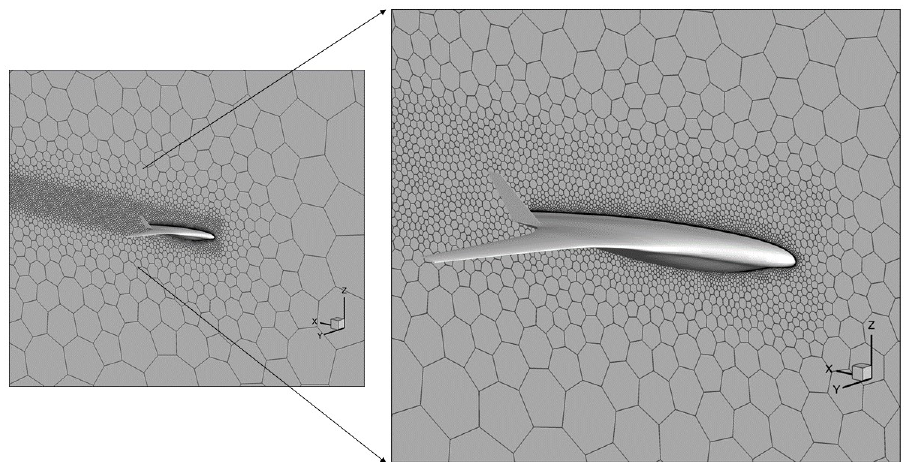
Figure 5. Unstructured polyhedral grid on the aircraft longitudinal plane. Details of mesh close to the aircraft.